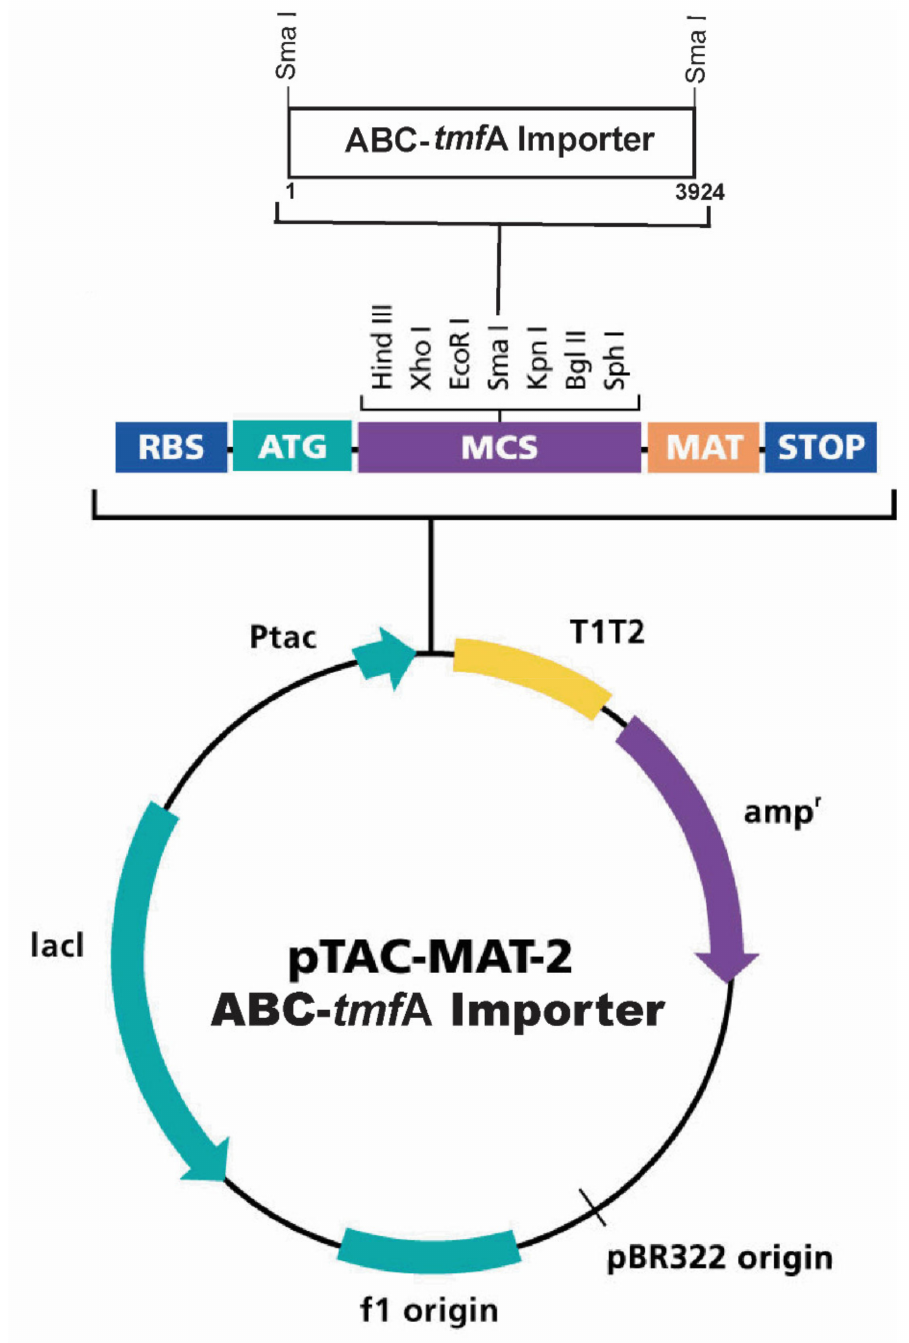
Figure 4. A graphic map of plasmid pTAC-MAT-2 that was used to directionally clone the Aea ABC- tmf A receptor gene at the Sma I cloning site. The plasmid is Amp R with a lac I gene allowing the use of IPTG to express the recombinant AeaABC-TMOF receptor in the inner membrane of E. coli